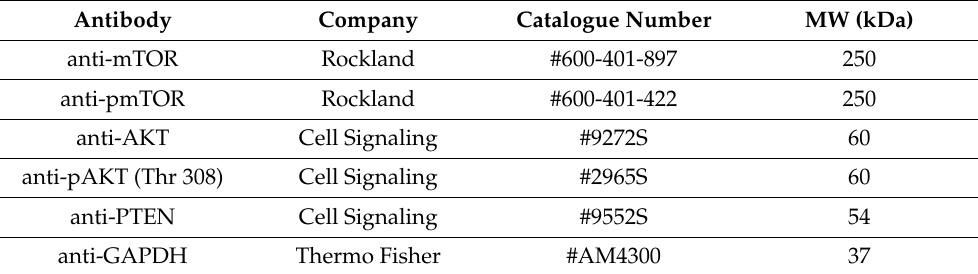
Table 1. Primary antibodies used in the